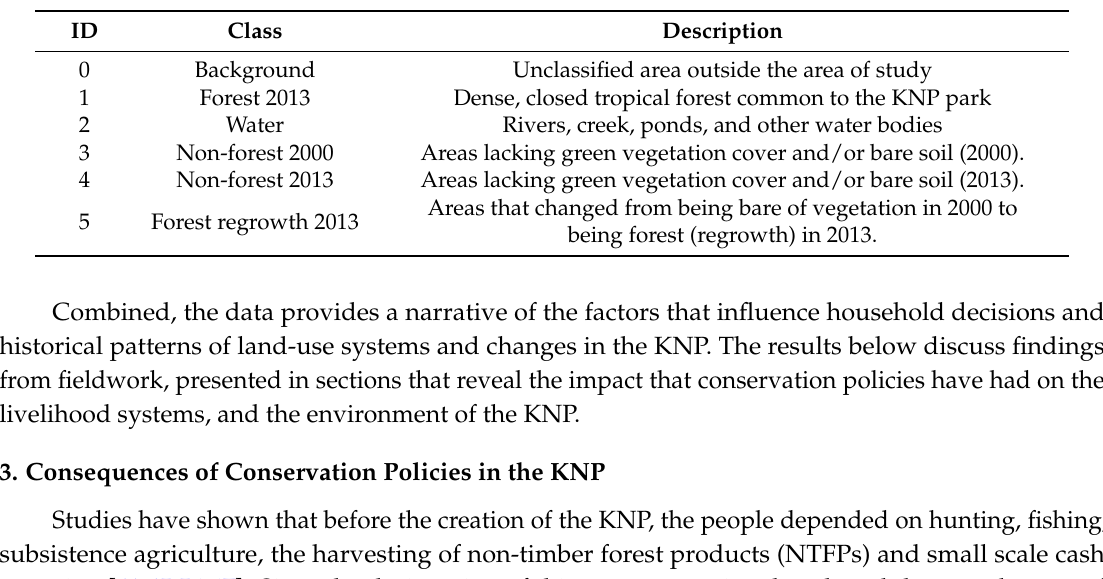
Table 1. Land use Classification